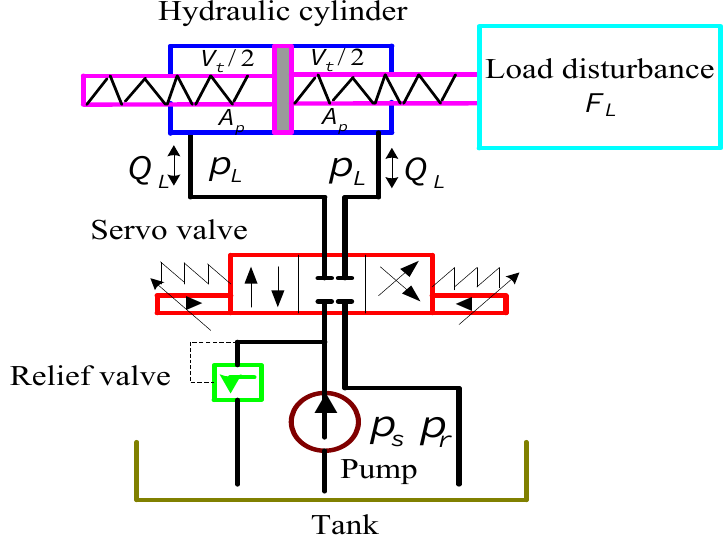
Figure 1. The EHS control